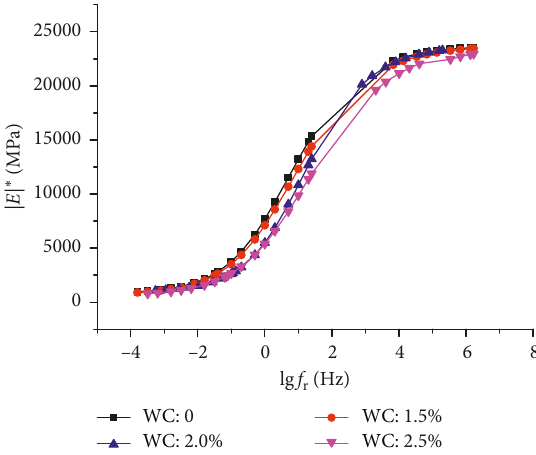
Figure 21: 70#AC-20-type dynamic modulus main curve.